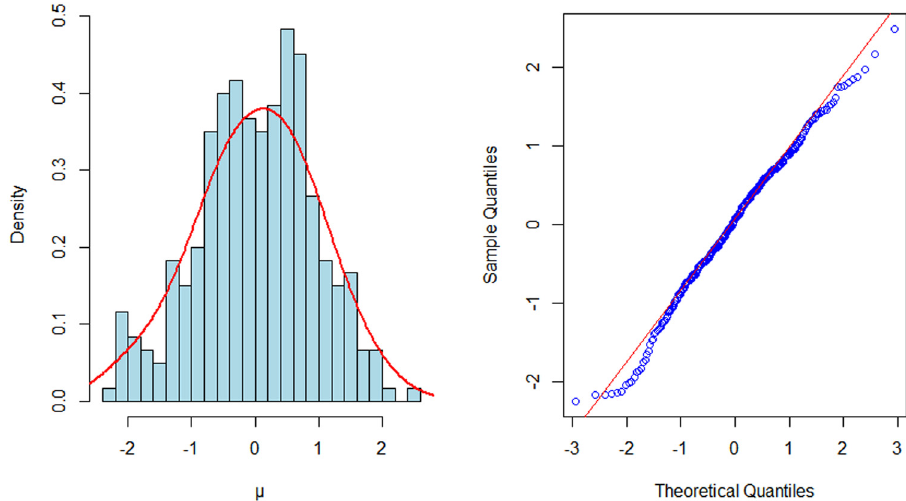
1−1 with = n 100 1 1 n